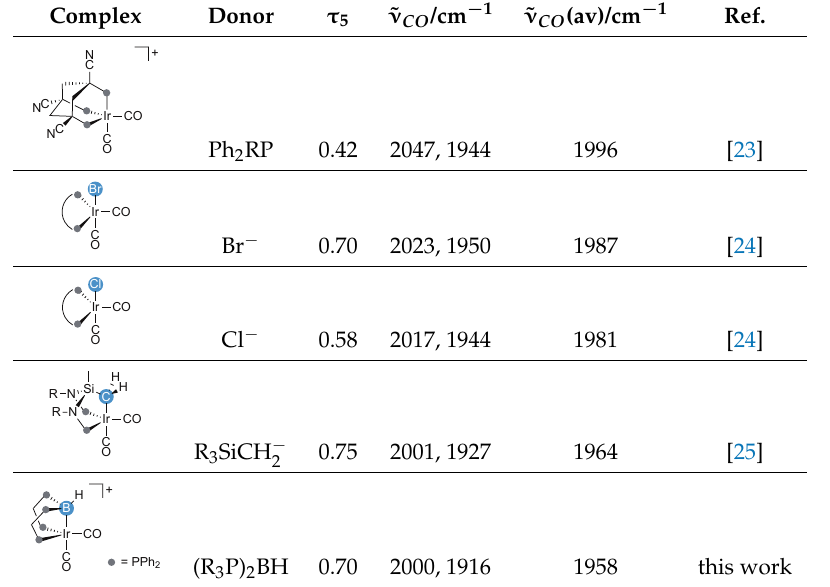
Table 2. Comparison of Iridium(I) dicarbonyl complexes from literature with the new complex 5c .